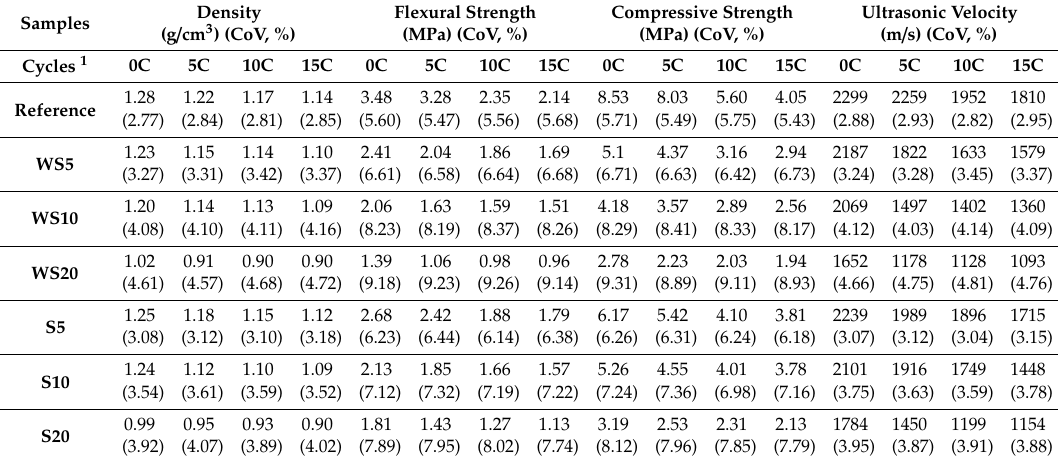
Table 4. Test results obtained for the composites after 0, 5, 10, and 15 wetting–drying